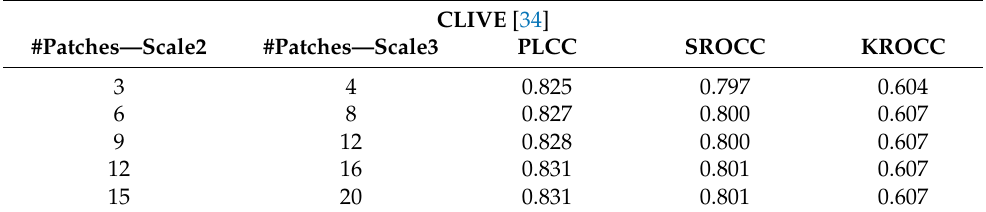
Table 4. Performance comparison on the effect of image patches’ number on CLIVE [34]. Median PLCC, SROCC, and KROCC values were measured over 100 random train–test splits.